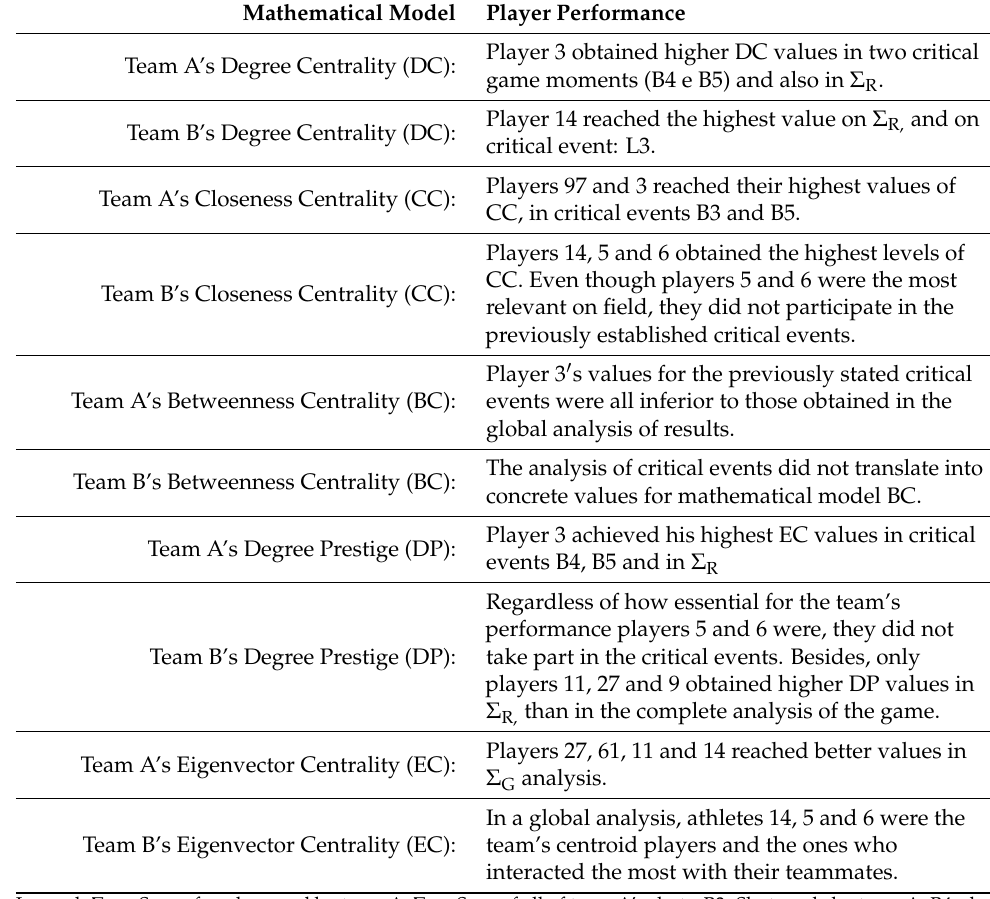
Table 2. Best performers according to mathematical model. Mathematical Model Player